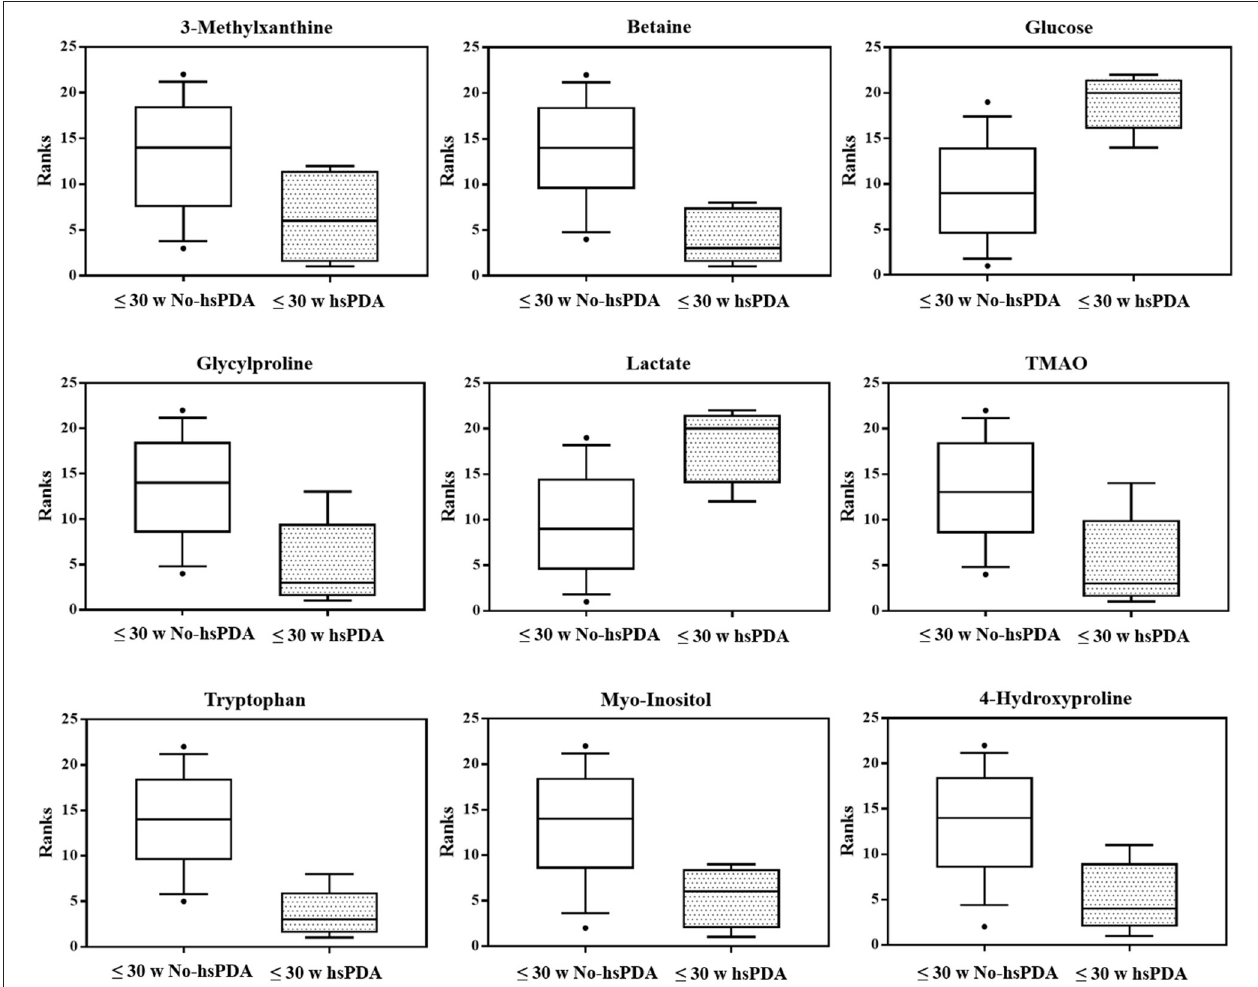
FIGURE 4 | Box-and-whisker plots showing progressive changes of the metabolites concentration on ≤ 30w No-hsPDA and ≤ 30w hsPDA urine samples. Statistical significance was determined using the Mann-Whitney U-test (two-tailed) and a p -value < 0.05 was considered statistically significant. The Benjamini-Hochberg adjustment was